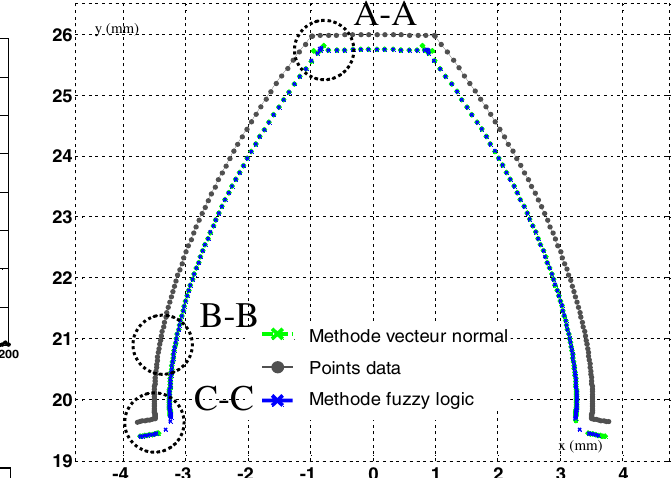
Fig. 6. (Color online) Value Δz i .